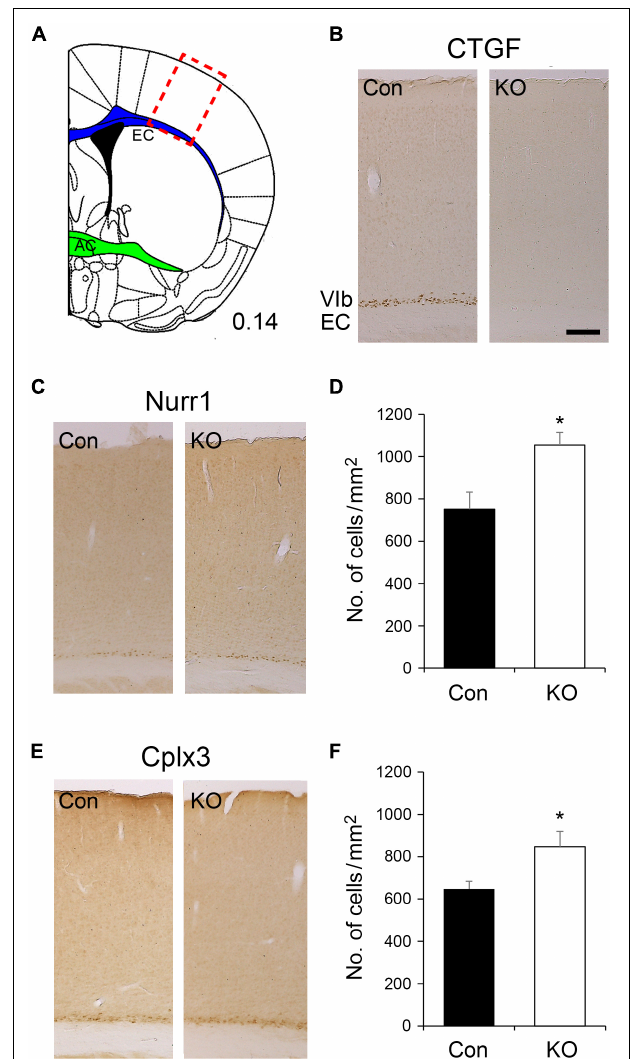
FIGURE 3 | Expression of subplate neuron markers in the layer VIb of the somatosensory cortex. The somatosensory cortex is labeled (red rectangle) in a brain section in which the external capsule (EC) is marked in blue while the anterior commissure (AC) is marked in green (A) . CTGF is expressed in the layer VIb neurons of control (Con) mice but not in forebrain-specific Ctgf knockout (KO) mice (B) . Nurr1 is expressed in layer VIb neurons of both controls and mutants (C) . A significantly higher density of Nurr1-positive cells was identified in Fb Ctgf KO ( n = 5) mice, compared with control ( n = 5) mice (D) . Cplx3 is a subplate neuron marker which is expressed in the layer VIb neurons of both control and Fb Ctgf KO mice (E) . Similar to Nurr1 immunostaining, the density of Cplx3-positive cells in Fb Ctgf KO ( n = 5) mice was higher than in controls ( n = 5) (F) . Scale bar is 200 µ m. Results are mean ± SEM ( ∗ p <